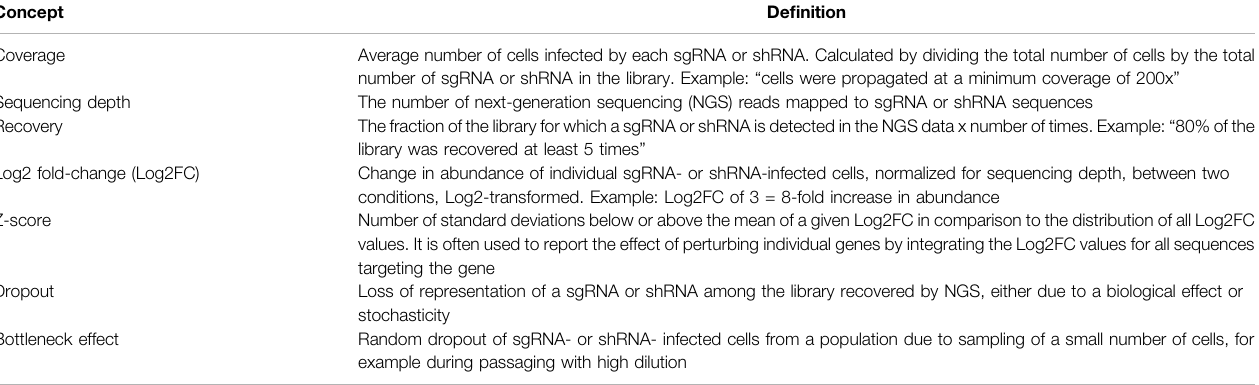
TABLE 1 | Frequently used concepts in CRISPR